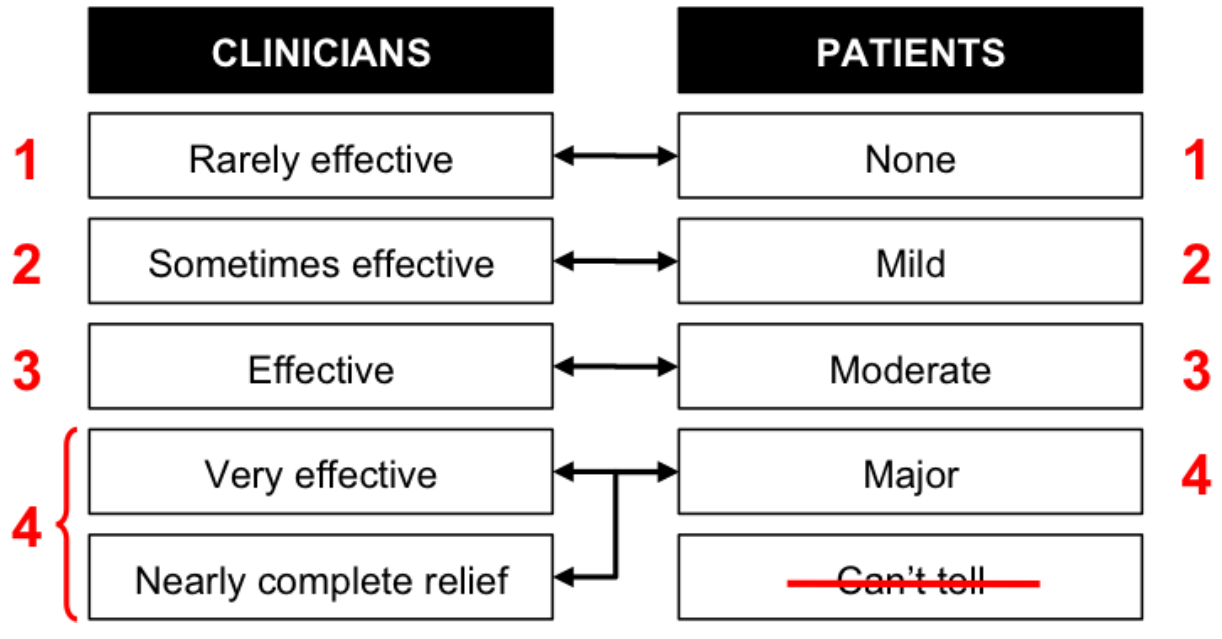
Figure 1. Adjustment of rating scales to enable